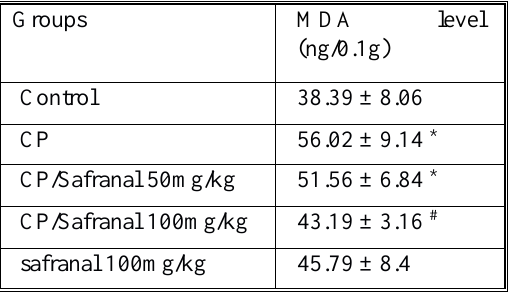
Table 5 . Effect of safranal on MDA level among various groups